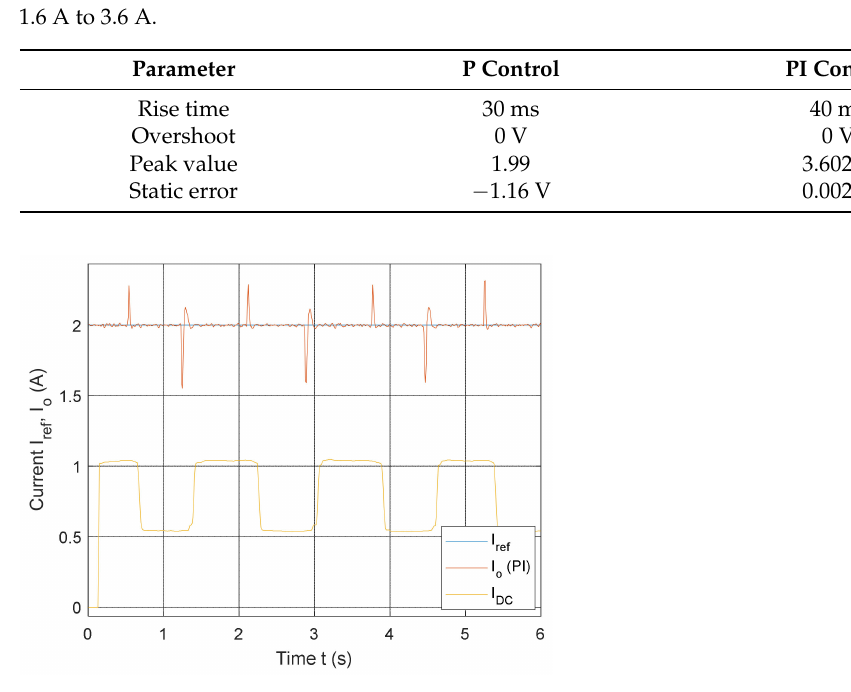
Figure 15. Closed-loop controller response to change in mutual inductance. ( a ) Horizontal movement and misalignment, ( b ) vertical movement between 15 mm and 30 mm. Table 8. Performance evaluation of different controllers, when changing the reference value I ref from